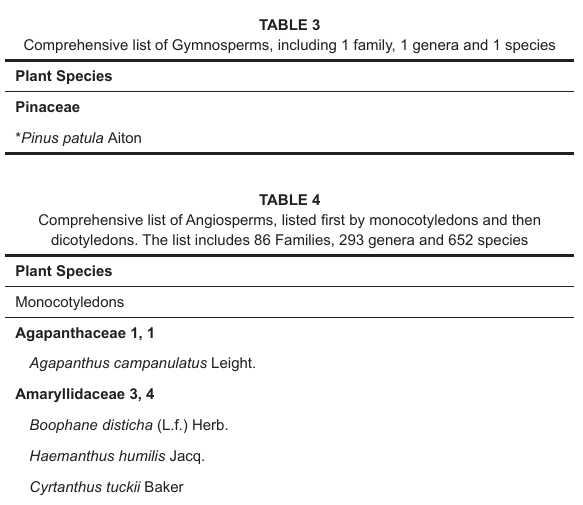
TABLE 3 Comprehensive list of Gymnosperms, including 1 family, 1 genera and 1 species